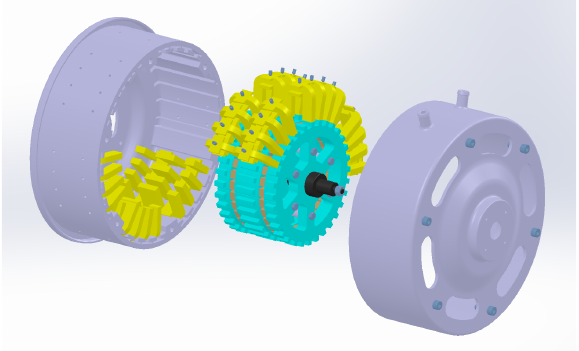
Figure 14. CAD drawing of the final prototype.